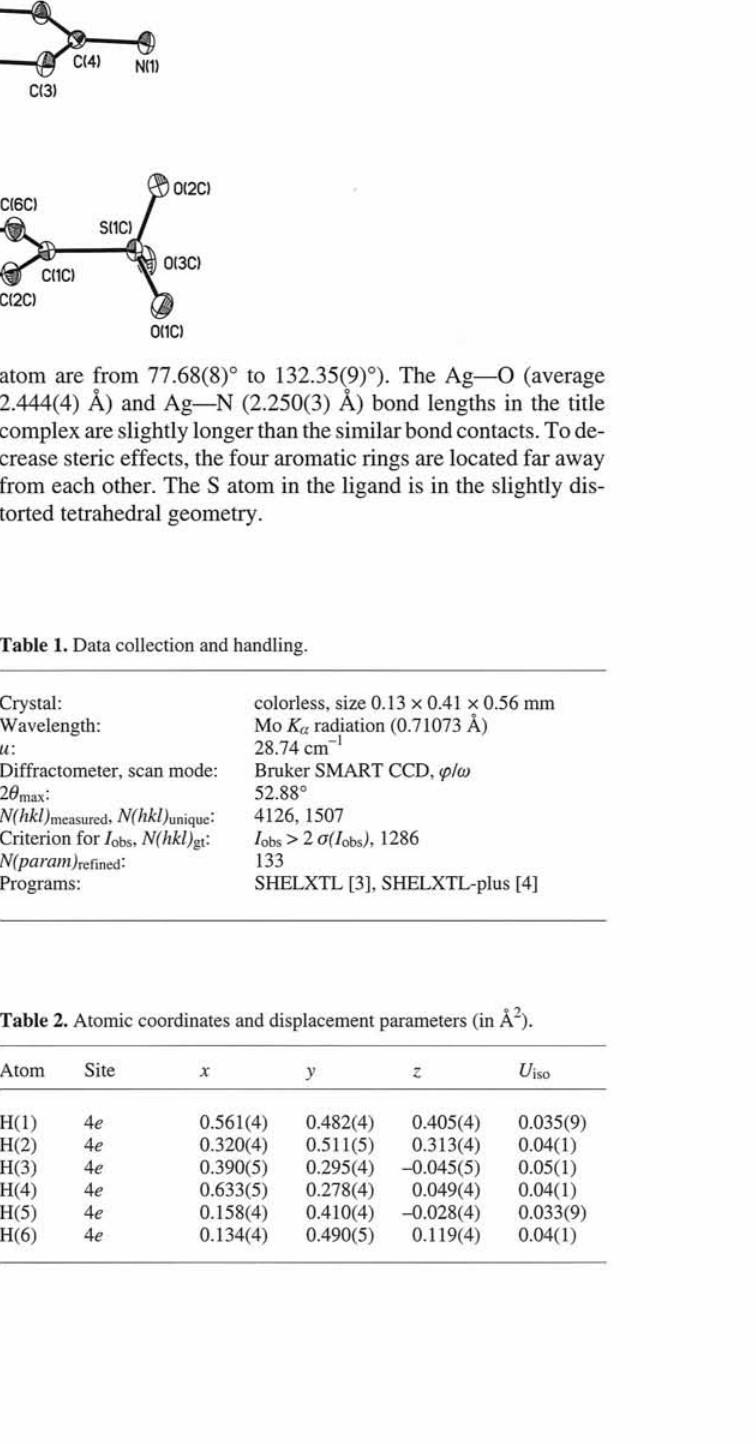
Table 2. Atomic coordinates and displacement parameters (in